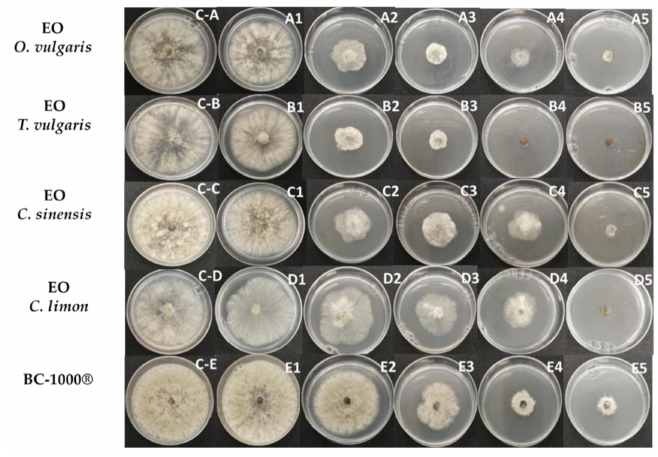
Figure 1. Effect of EOs, obtained from O. vulgare , T. vulgaris , C. sinensis , and C. limon , on mycelial growth of B. cinerea in PDA. EOs and positive control (BC-1000 ® Dust) were applied at different concentrations (% v / v ): ( C-A – C-E ) (negative control), 0.0; ( A1 – E1 ) 9 × 10 − 4 ; ( A2 – E2 ) 9 × 10 − 3 ;